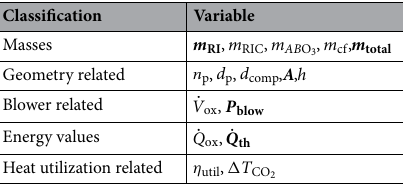
Table 8. Resulting values for the energy optimization. Hereby, the highlighted values of m total , m RI , P blow are optimized.